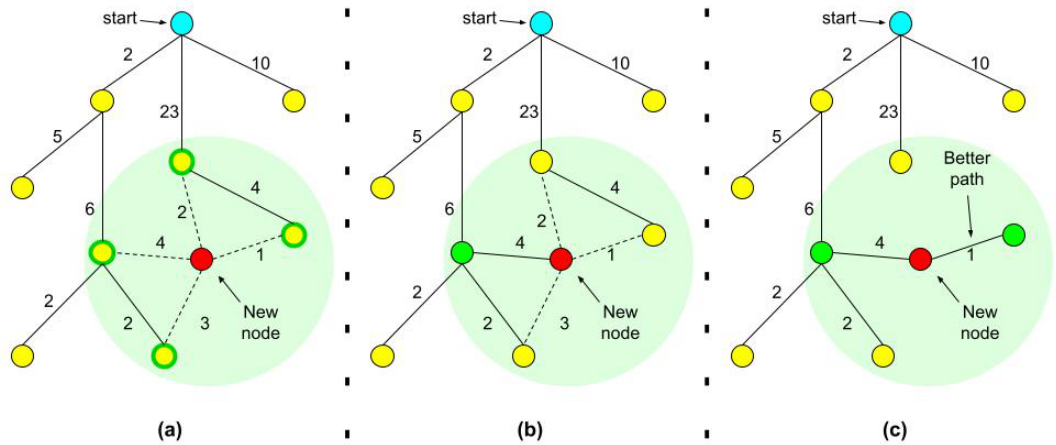
Figure 1. Illustration of RRT* best (least-cost) parent search and the rewiring process. ( a ) A new node is added to the tree and nearest neighbors are highlighted. ( b ) The best parent is chosen among nearest neighbors. ( c ) Costs of rewiring are checked and the tree is